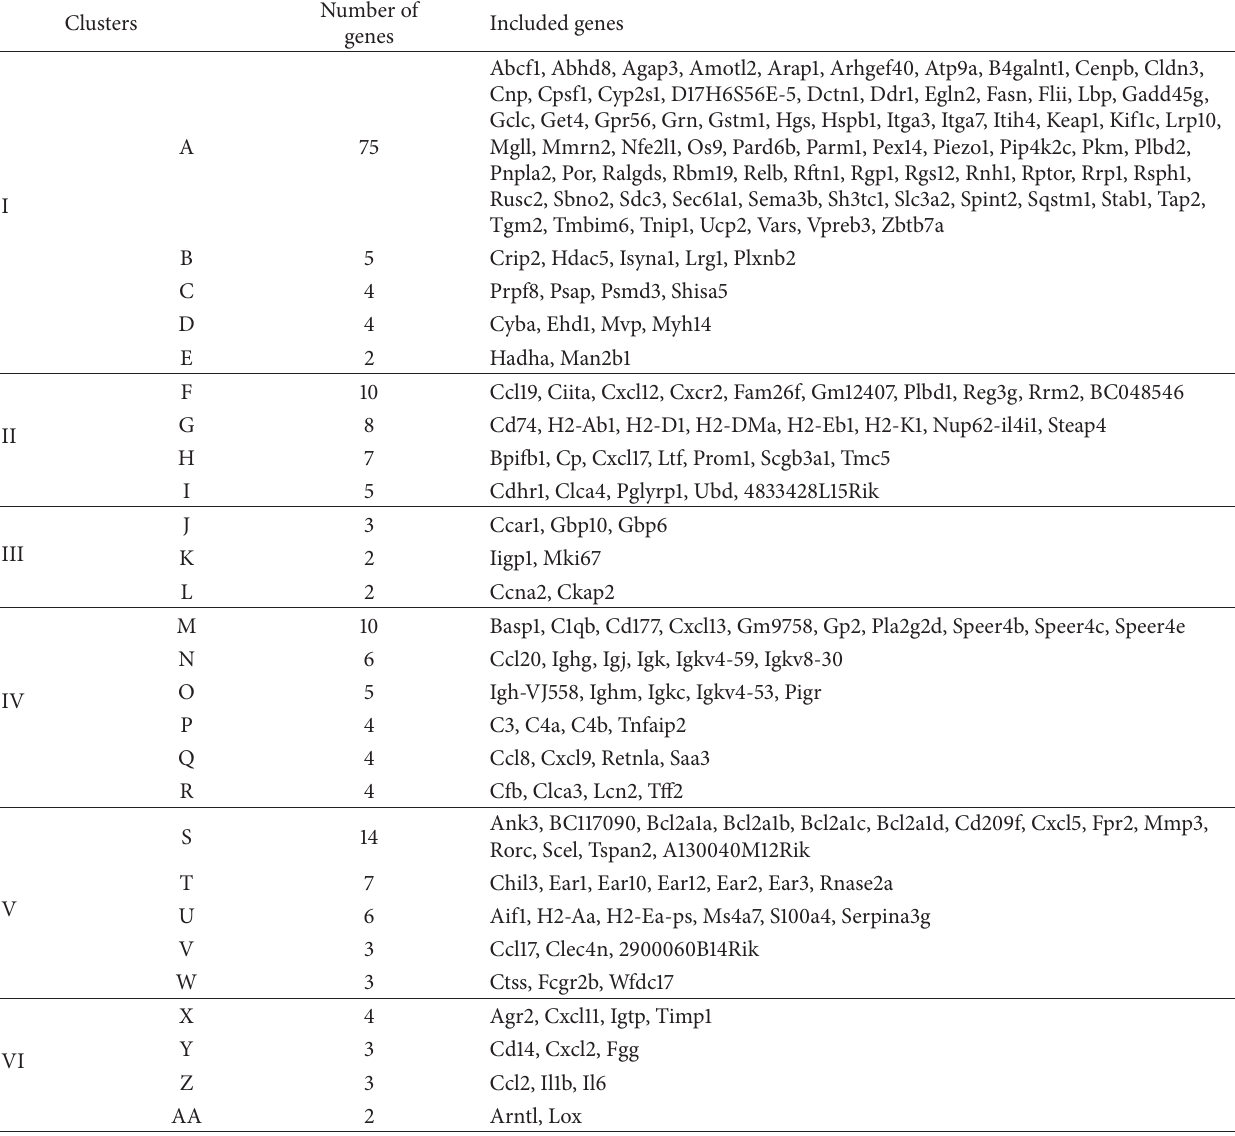
Table 1: Detailed information on the 27 gene